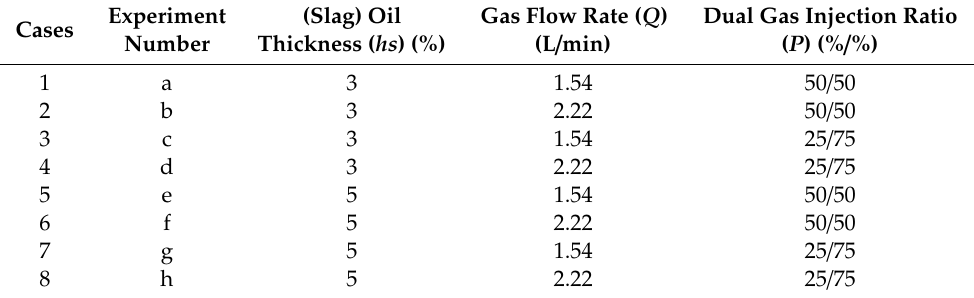
Table 2. Design of experiment with high and low values of the three variables, namely, gas flow rate, dual gas injection ratio and (slag) oil thickness for the eight case studies presented in this study.